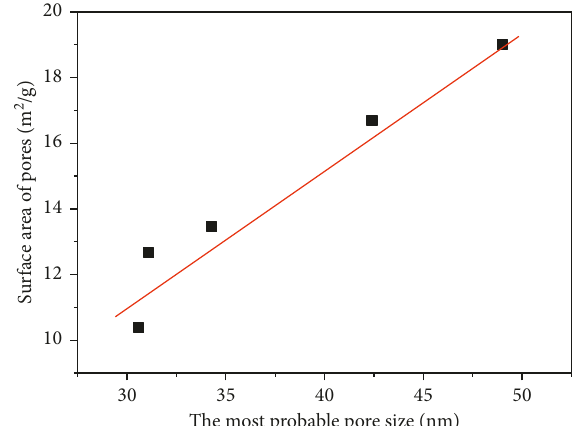
Figure 11: Relation between the most probable pore size and total surface area of pores.